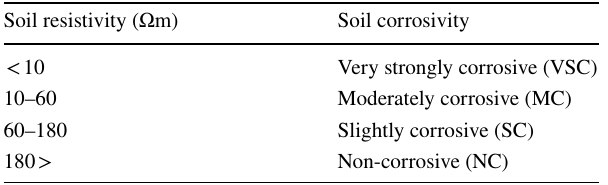
Table 2 Classification of soil resistivity in terms of corrosivity (Bae- ckmann and Schwenk 1975; Agunloye 1984; Oladapo et al. 2004) Soil resistivity